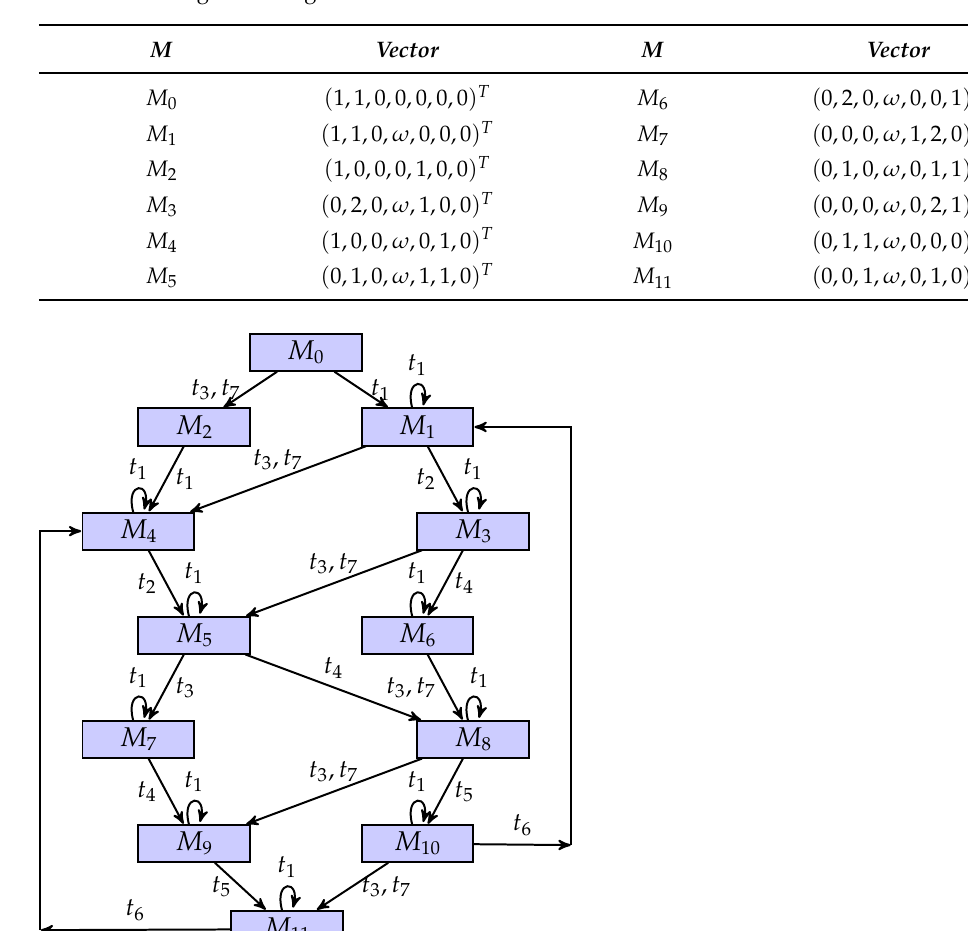
Figure 3. An unbounded Petri net. Table 1. Markings list of Figure 3.